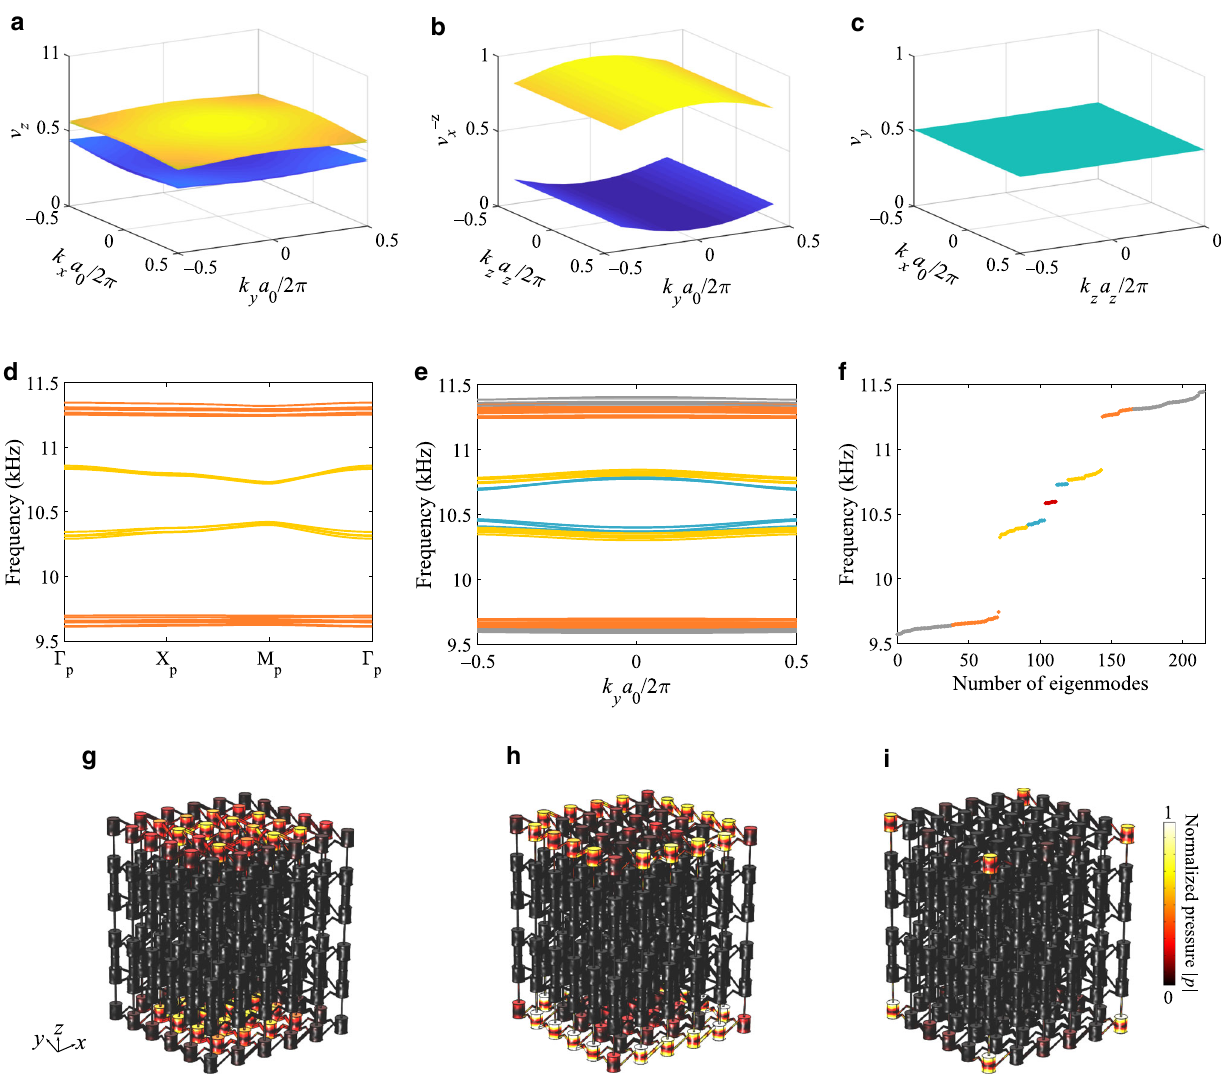
Fig. 2 Higher-order topology and corresponding boundary states of the acoustic tetragonal crystal. a – c n th-order Wannier bands obtained based on the fi rst-principle FEM simulation. a First-order Wannier bands v z of the selective energy bands below the bandgap shown in Fig. 1c. b Second-order Wannier bands ν (cid:2) z x of the Wannier-sector − v z . c Third-order Wannier bands ν (cid:2) x ; (cid:2) z y of the Wannier sector (cid:2) ν (cid:2) z x . d – f Energy bands show hierarchy topological states in which ( d ), energy bands of the supercell lattice (110) supporting the surface states (yellow-colored bands). e Energy bands of the supercell lattice (010) supporting the hinge states (blue-colored bands). f Energy diagram of a fi nite lattice composed of 3 × 3 × 3 unit cells supporting mid-gap edge polarization- induced corner states. g – i Surface, hinge and corner fi eld distributions over the fi nite lattice integrated from the respective boundary eigenstates inside the bulk bandgap in ( f ). Surface and hinge states in the vertical boundaries are mixed and represented by gray-colored bands in ( f